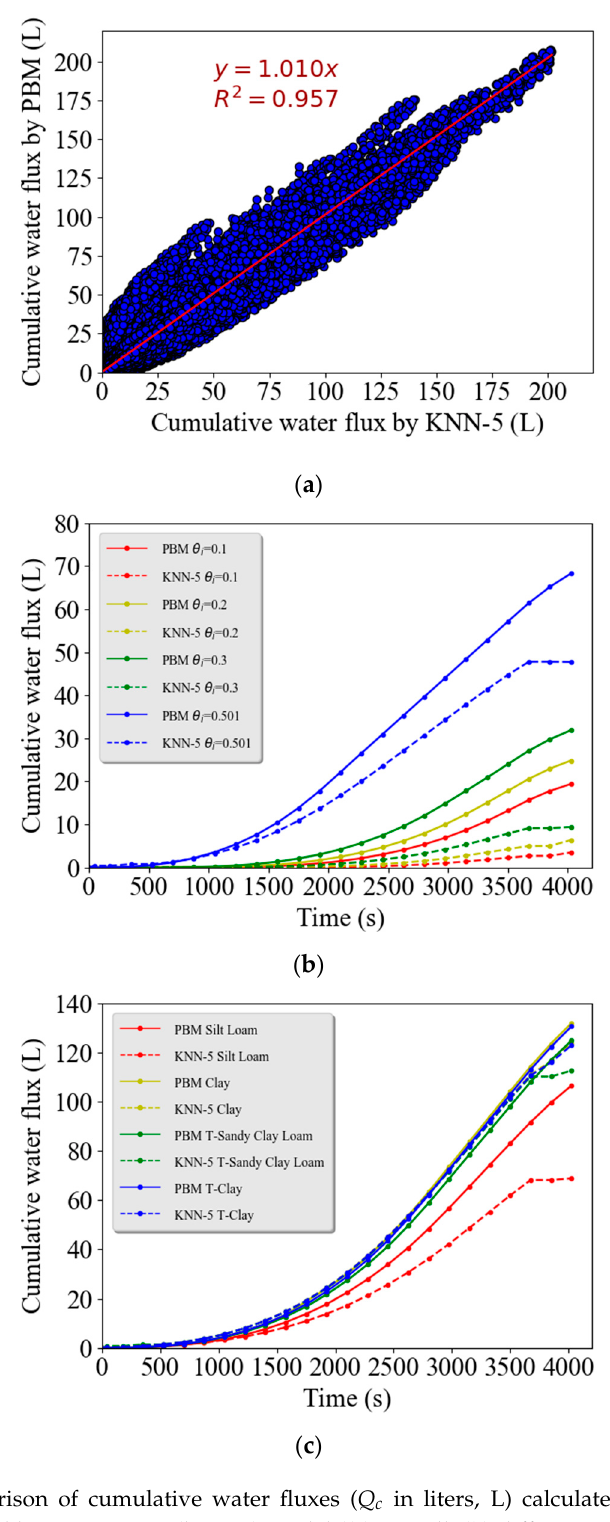
Figure 6. Comparison of cumulative water fluxes ( Q c in liters, L) calculated by the PBM and the k-Nearest Neighbor Regression (kNN-5) model (( a ) overall, ( b ) different initial water contents, ( c ) different textures)).